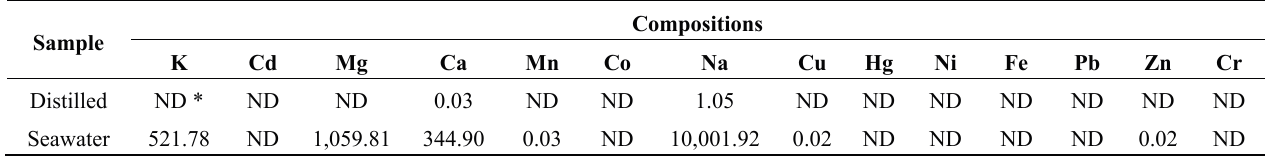
Table 1. The element compositions of the tested water samples. (Unit in ppm